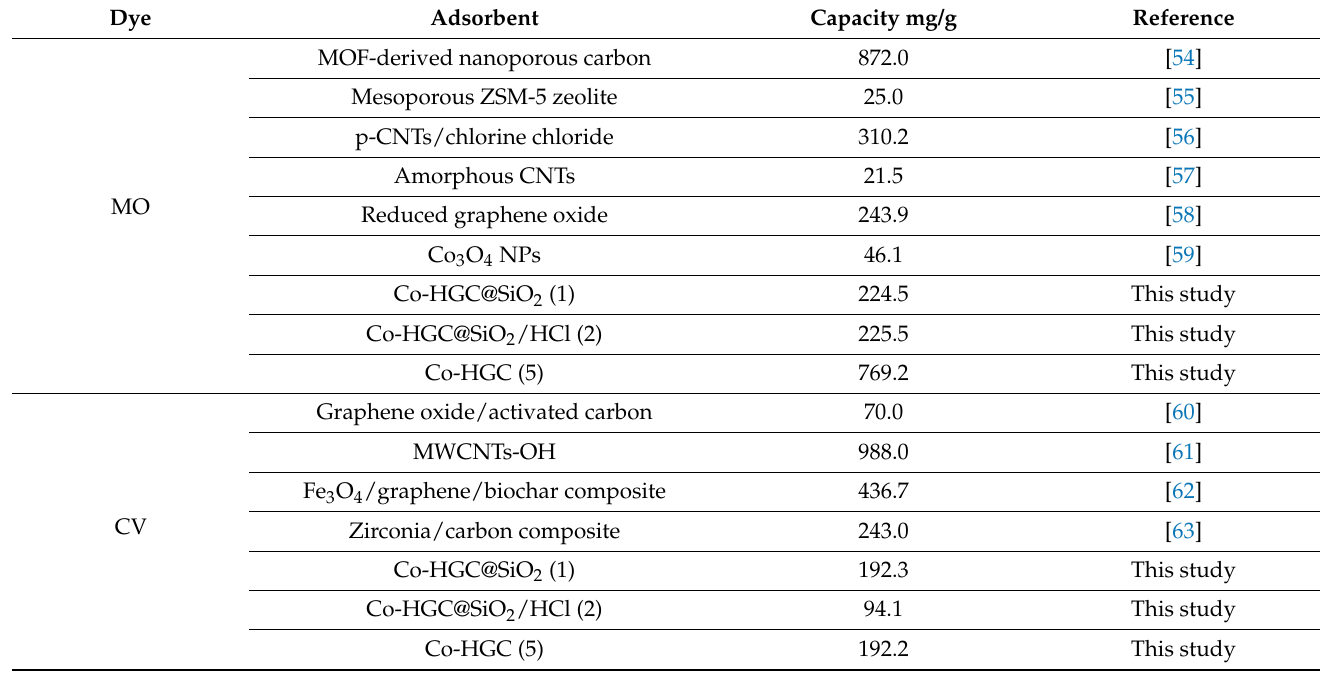
Table 4. Comparison of adsorption capacity of the new adsorbents (1), (2) and (5) for uptake of CV and MO dyes with other